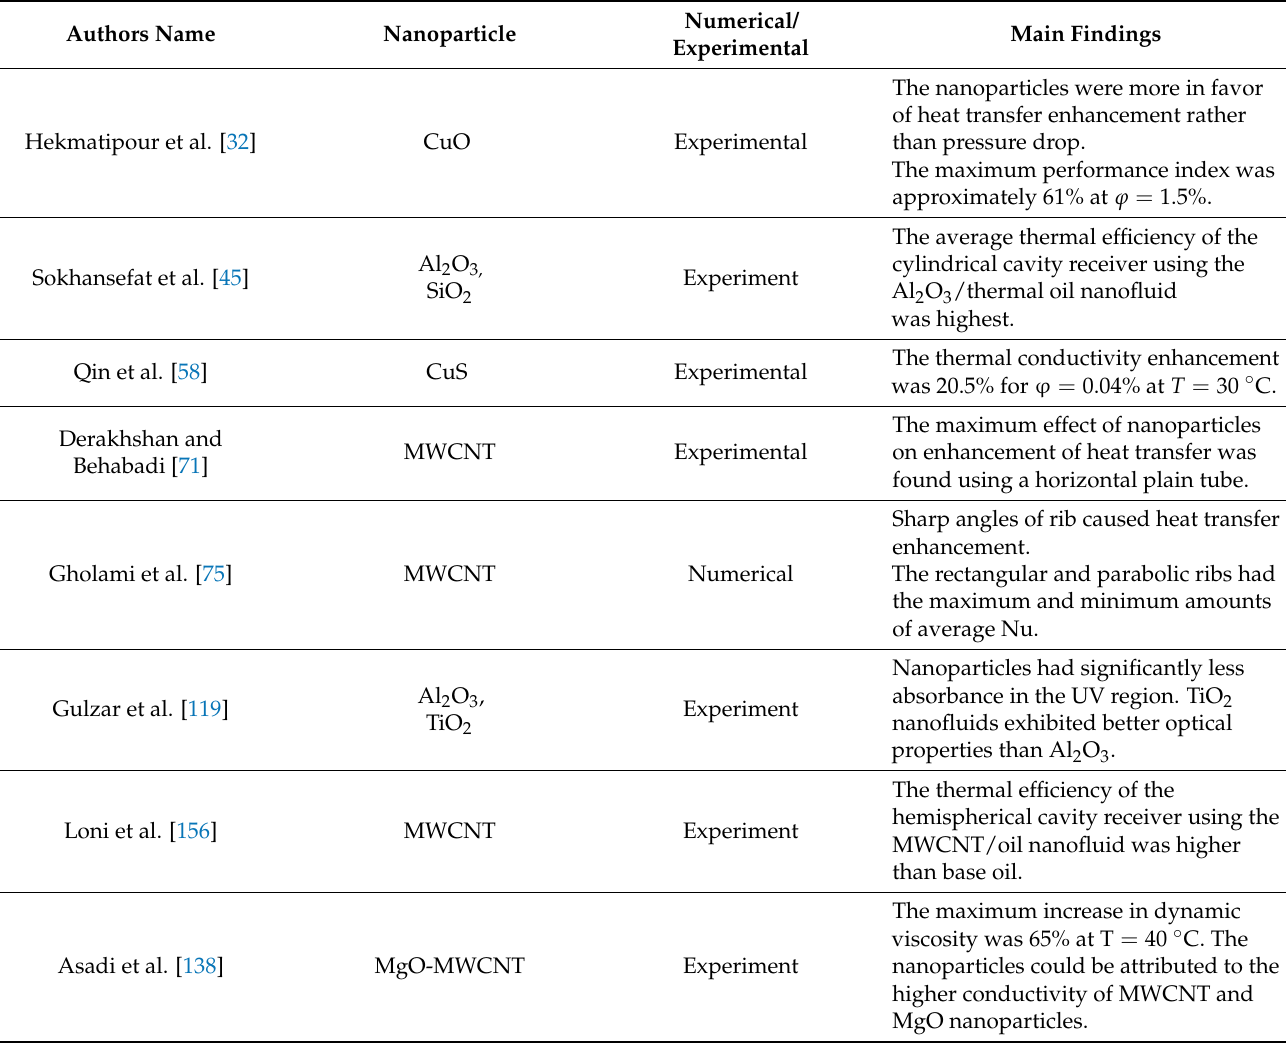
Table 13. Comparison of previous investigations on thermal-oil-based